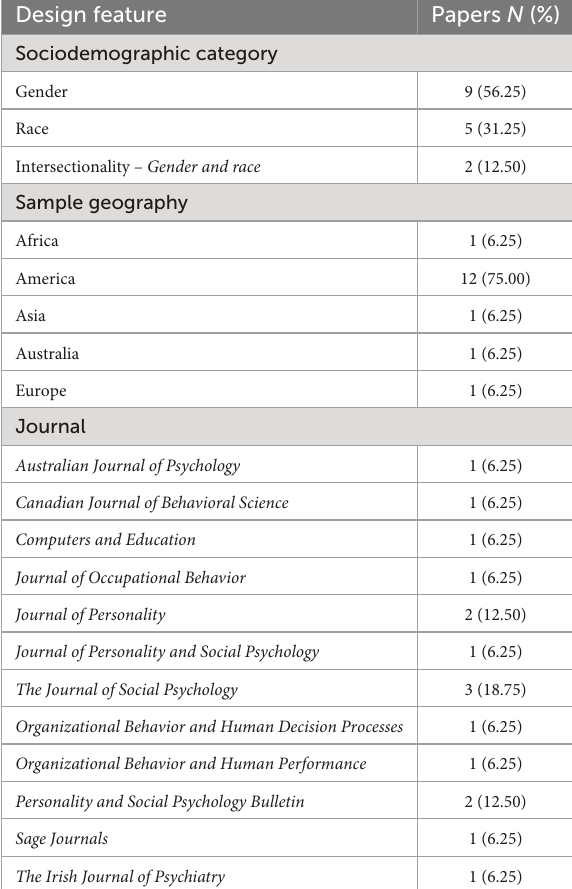
TABLE 2 Summary of review